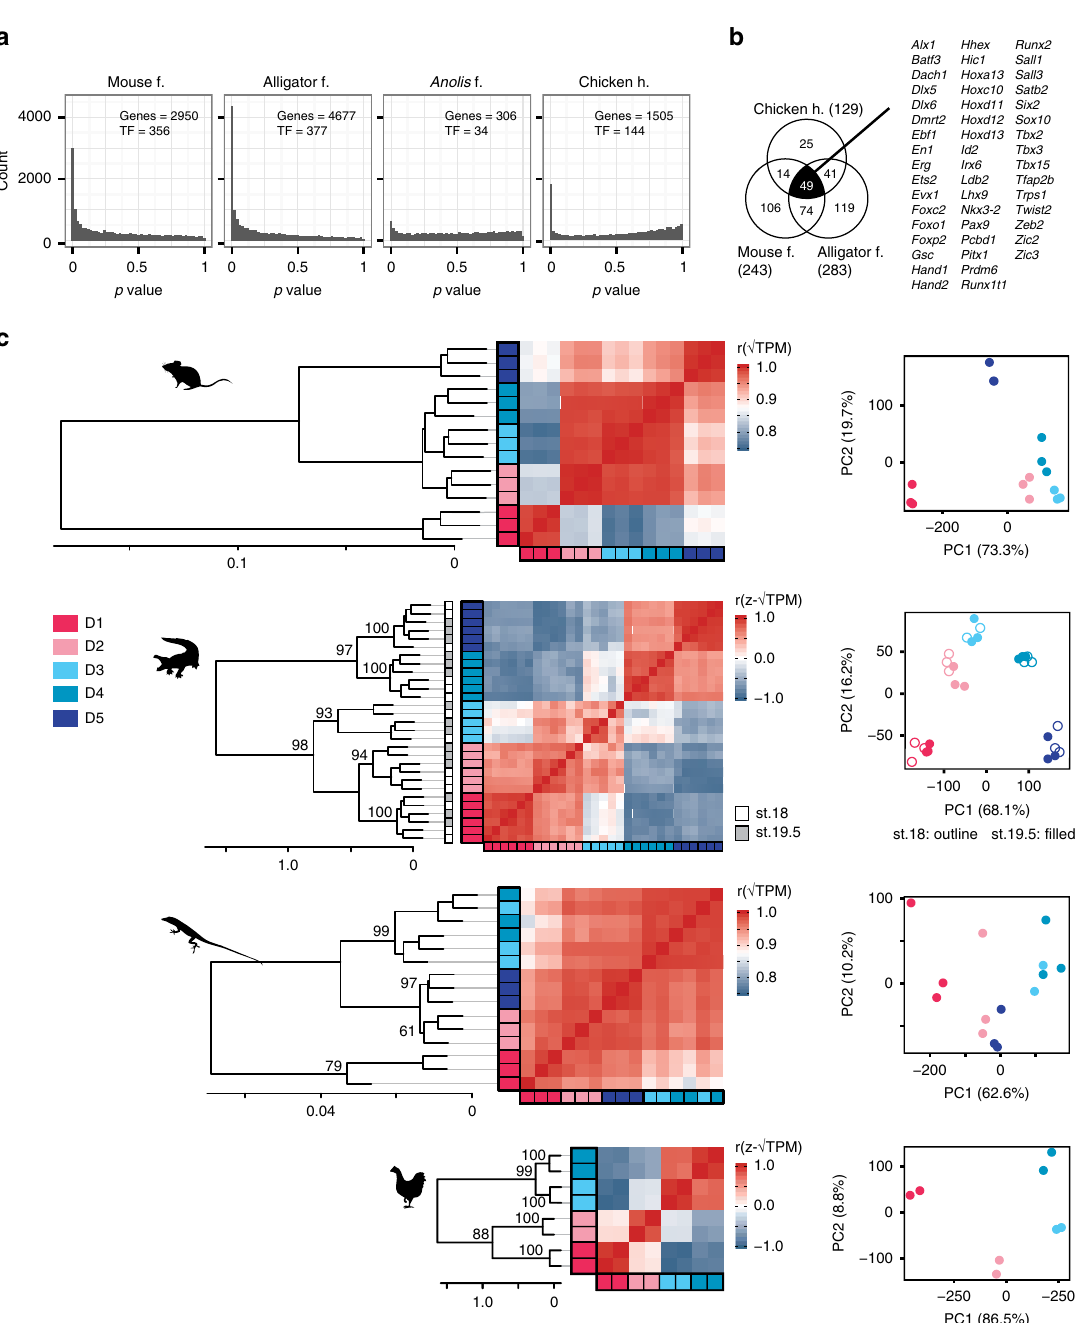
Fig. 5 A conserved core set of digit patterning genes in amniotes. a ANOVA comparing all combination of digits within limbs. The number of genes identi fi ed as differentially expressed at a FDR threshold of 0.05 are noted in each panel as “ genes. ” The number of transcription factors among these are noted as “ TF. ” b Venn diagram showing one-to-one orthologous transcription factor genes that are differentially expressed across mouse, alligator, and chicken limbs. c HCA and PCA show these genes can recover patterns of digit correspondence similar to analyses of limb patterning genes and transcription factors. Alligator and chicken illustrations reproduced with permission by Michael Richardson. Anolis illustration by Sarah Werning